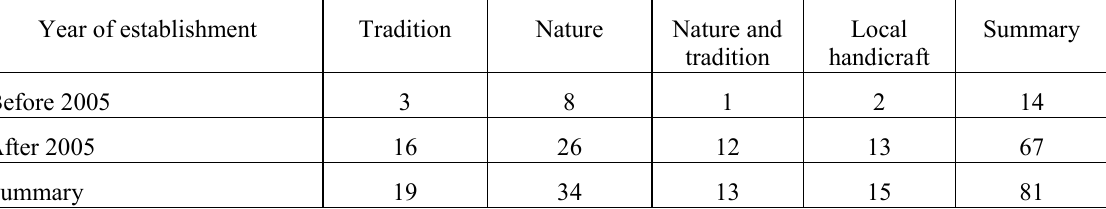
Table 1.Identification of tourism village growth in Yogyakarta base on year of